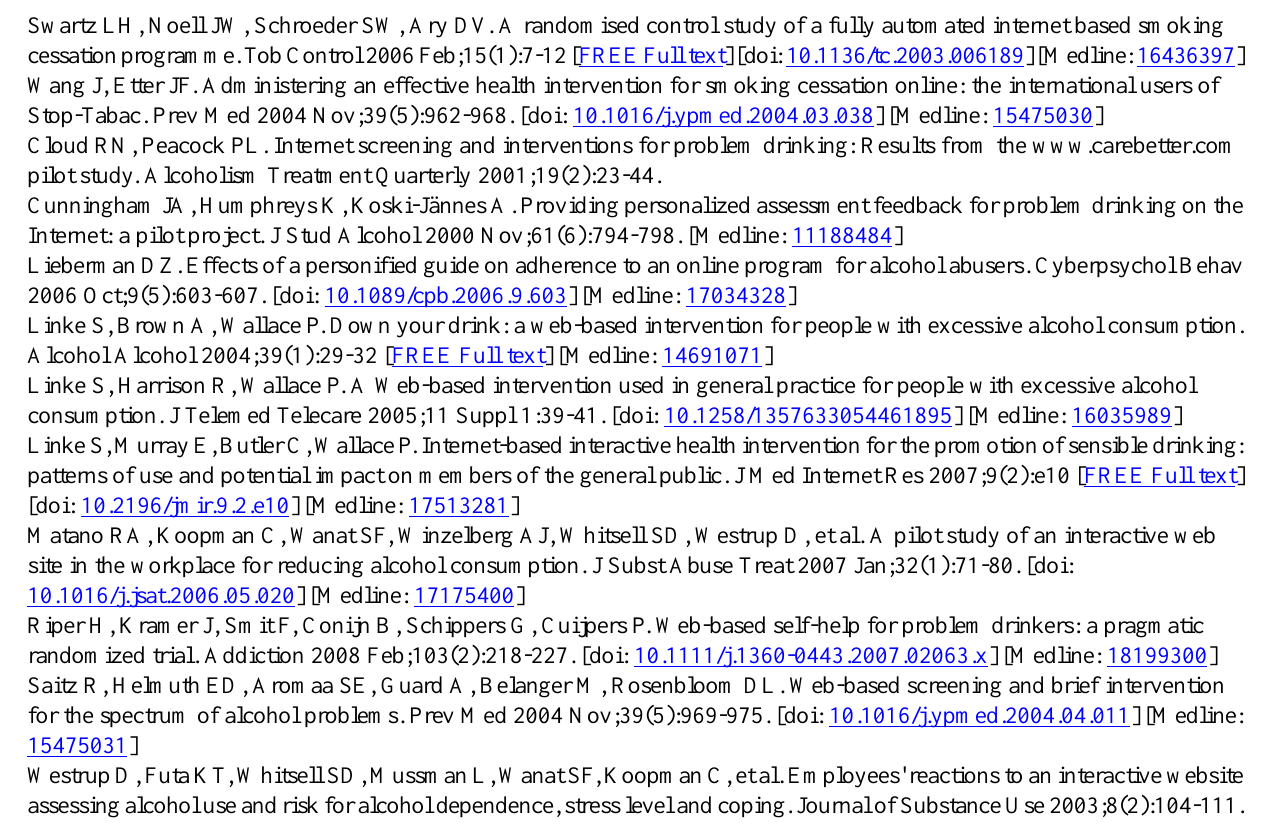
RCT: randomized controlled trial